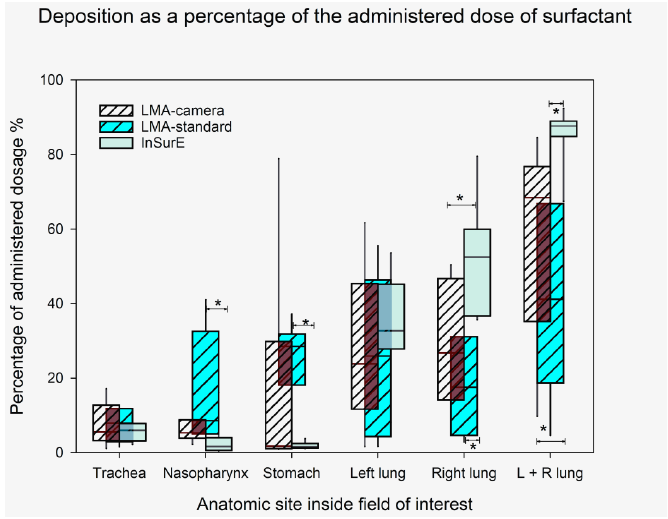
Figure 6. Deposition as a percentage of the administered dose. Box plot (median, 5th, 95th percentiles) for the deposition calculated as a percentage of the administered dose for the different anatomical sites inside the region of interest. * is p < 0.05 (Analysis of variance with Dunn ’ s post hoc test).